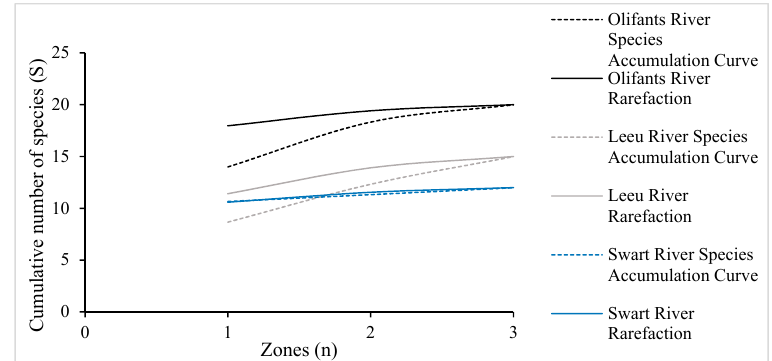
Figure 1. Species accumulation (observed, dotted line) and Rarefaction (expected, solid line) curves for riparian plants at Olifants (Black), Leeu (Grey), and Swart (Blue) river, Western Cape, South Africa. The total number of woody species is 20, 15, and 12, respectively. The curves represent successively pooled and randomly ordered samples between three different zones sampled. Curves were computed using Estimate S [33].